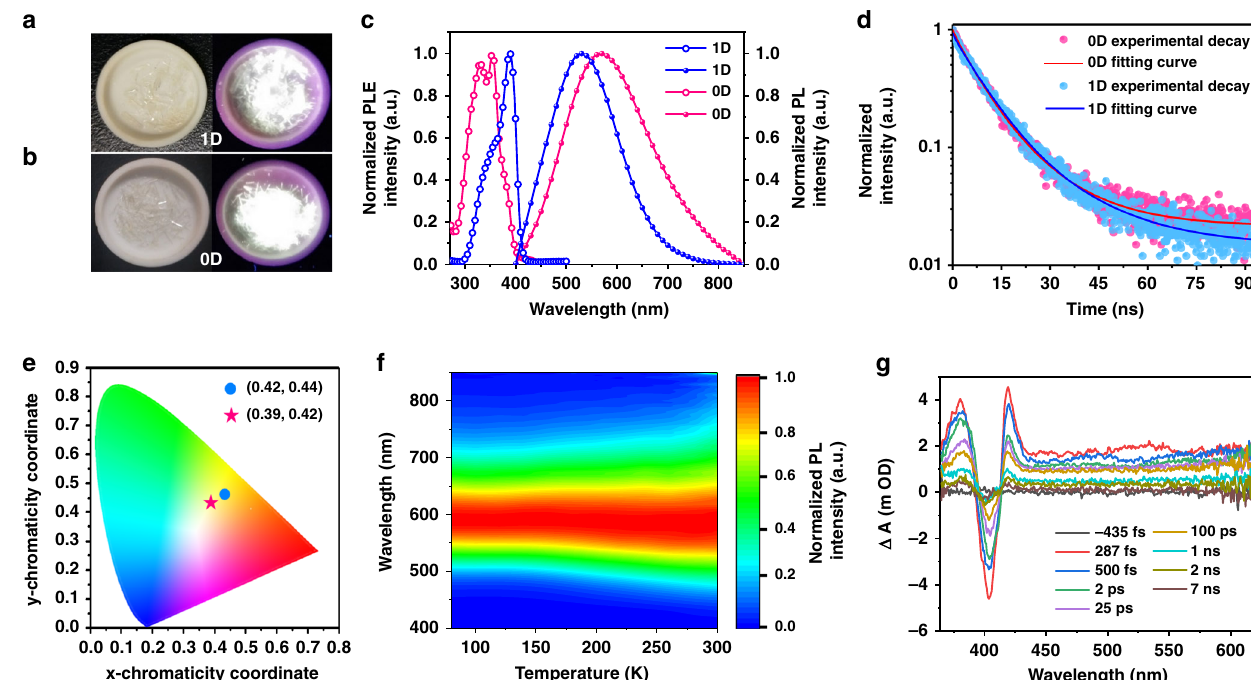
Fig. 3 Photophysical properties of 0D and 1D lead bromide perovskites. a , b Photos of 1D and 0D crystals in ambient and under UV light (365 nm), respectively. c Excitation (open circle) and emission (circle) spectra of 1D (blue) and 0D (pink) crystals at room temperature. d Time-resolved PL experimental decay (circle) and fi tting curve of the 0D (red line) and 1D bulk crystals (blue line) probed at 568 nm and 530 nm, respectively. e CIE chromaticity coordinates of 1D (dot) and 0D (star) crystals. f Temperature dependent emission spectra of 0D (C 3 H 11 N 3 O) 2 PbBr 6 ·4H 2 O crystals.